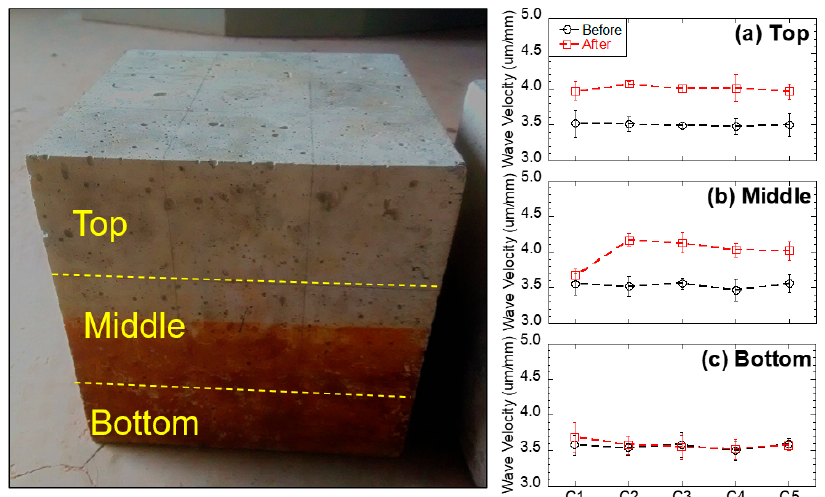
Figure 6. Measured ultrasonic velocity of concrete samples before and after the experiment: ( a ) top, ( b ) middle, and ( c ) bottom layers.